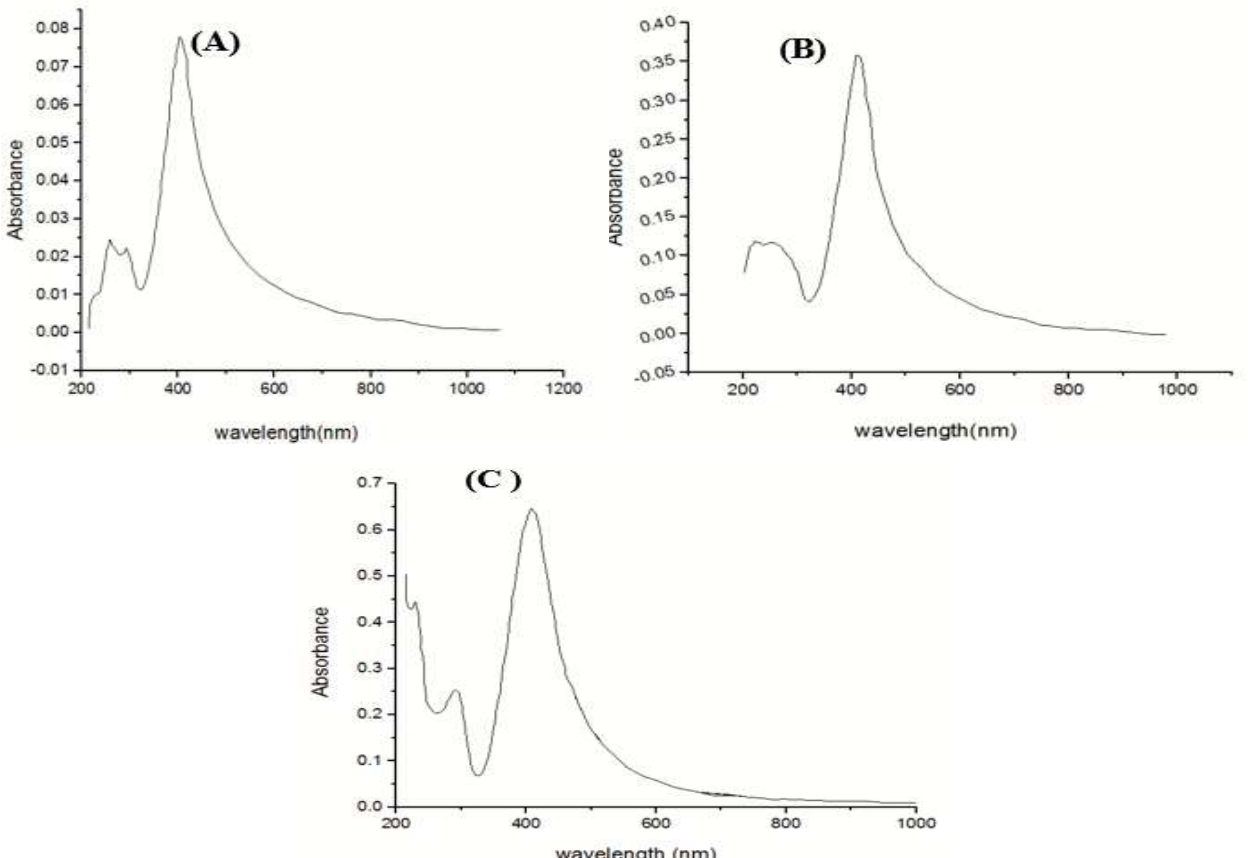
Figure 2: UV-Visible of Al 2 O 3 NPS at (A) 500 mJ, (B) 800 mJ, and (C) 1000 mJ